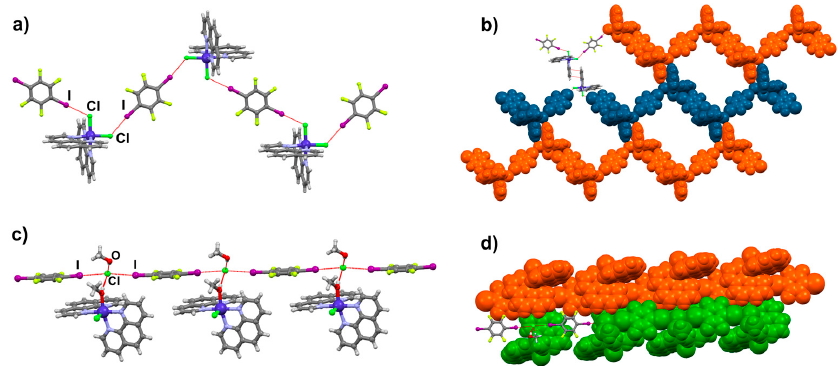
Figure 5. Parts of the crystal structure of prepared solids: halogen bonded zig-zag chain ( a ) and 2D network ( b ) of 1 ; and halogen bonded chain ( c ) and 2D network ( d ) of 2 . The asymmetric unit of 2 contains the [CoCl(MeOH)( phen ) 2 ] + cation complex, a Cl − anion, a